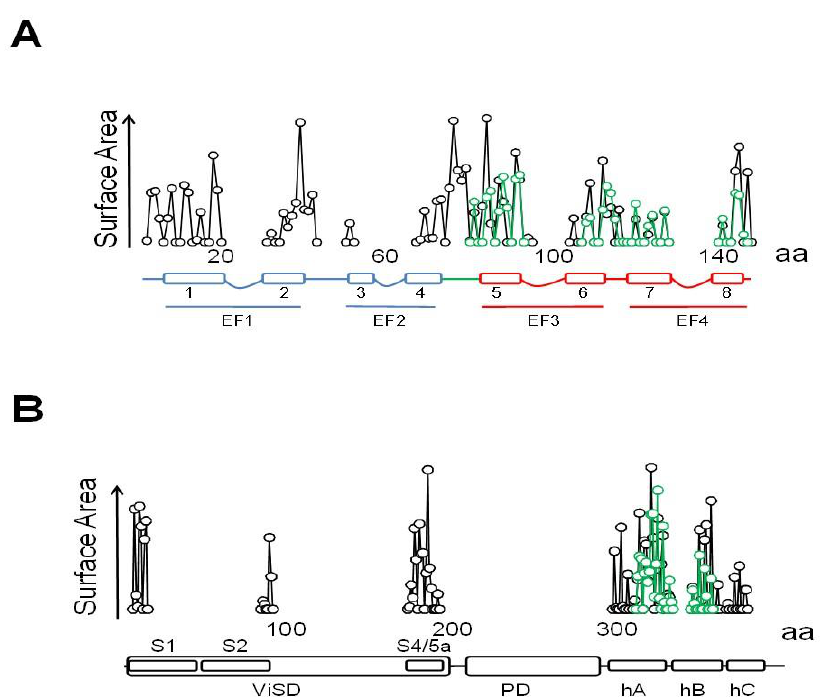
Figure 5. Plot of the contact surface per residue in CaM (A) and SK4 (B) in apo (green) and loaded with Ca 2+ (black). (Based on PDB 6CNM, 6CNN and 6CNO).